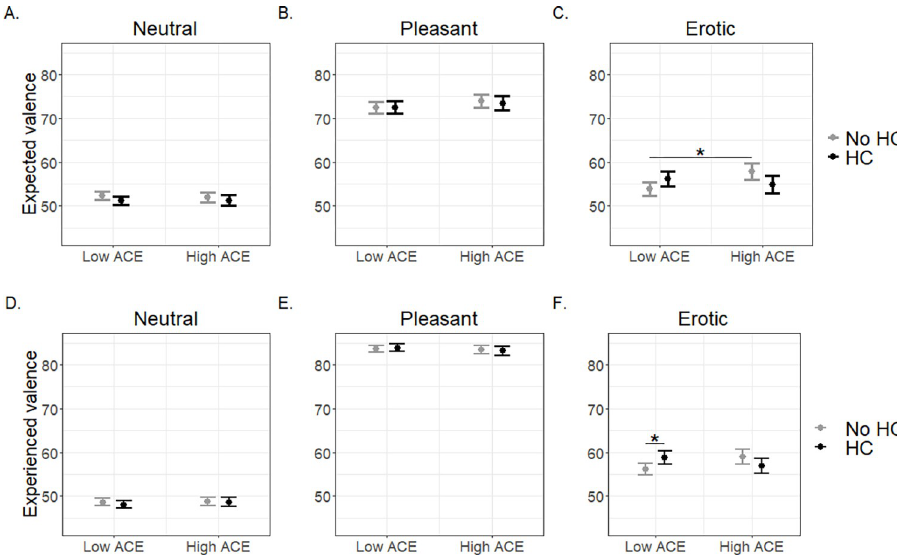
Fig 2. A-F. Expected and experienced valence ratings for different image types according to hormonal contraception (HC) use and prepubertal adverse childhood experience (ACE) group. A-C: For erotic images, but not neutral and pleasant images, hormonal contraception (HC) use and prepubertal ACEs interacted to predict expected valence ( p = 0.028). Specifically, in the group not currently using HC, those in the high ACE group anticipated a higher valence for erotic images than those in the low ACE group ( p = 0.020). D-F: For erotic images, but not neutral and pleasant images, hormonal contraception (HC) use and prepubertal ACEs interacted to predict experienced valence ( p = 0.025). Specifically, in the low prepubertal ACE group, those currently using HC experienced a higher valence for erotic images than those not currently using HC ( p = 0.020). Low ACE = 0 to 1 ACEs. High ACE = 2+ ACEs.